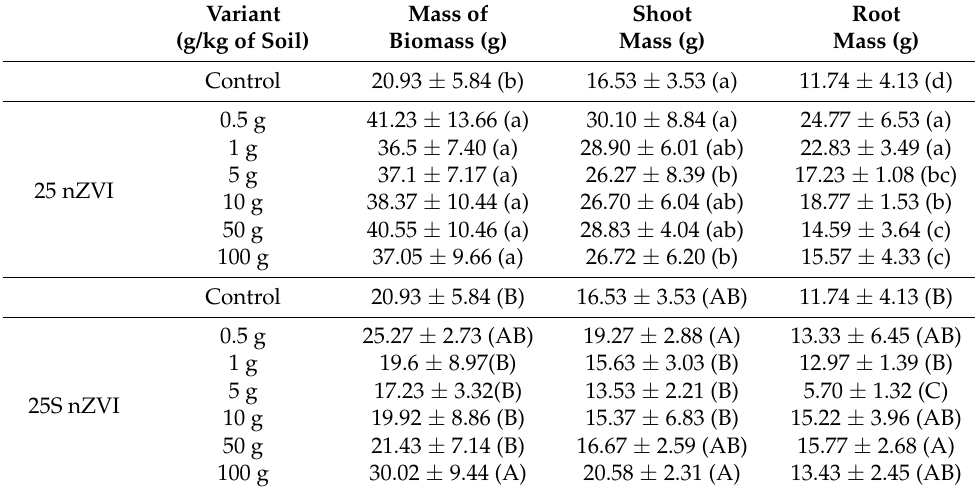
Table 2. Plant biomass after cultivation in soil supplemented by 25 nZVI and 25S